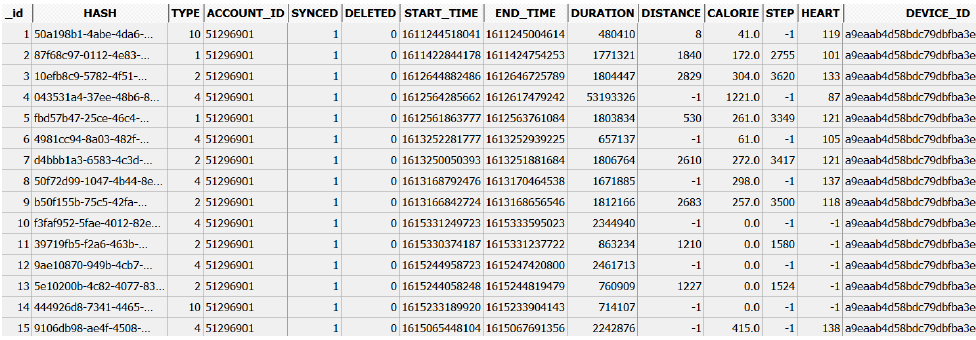
Figure 25. A reduced view of the different activities recorded in the RECORD table of the Mobvoi fitness.db database.